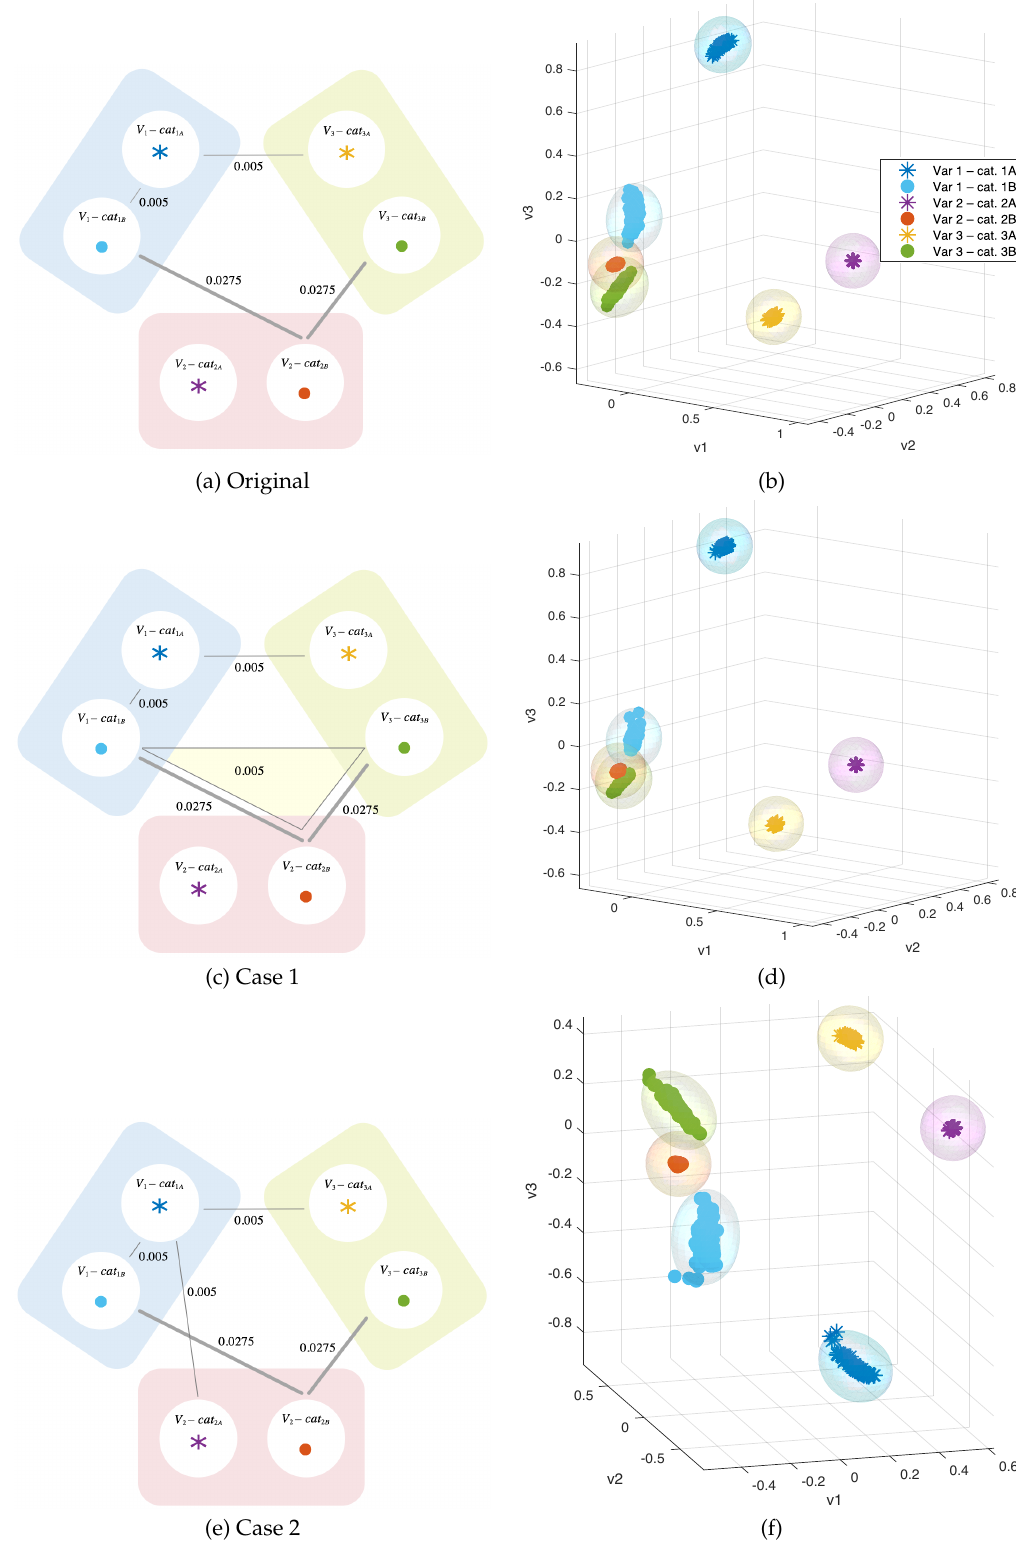
Figure 2. Schemes of the three situations to be scrutinized in the toy example ( a , c , d ), where V i with i = 1, . . . ,6 is the i th variable and cat ij with i = 1, . . . ,6 and j ∈ { A , B } the j jl category corresponding to the i th variable. The joint probability of occurrence is shown with a line of different thickness according to its value. The individual probabilities are obviated, as they are equiprobable. In ( b , d , f ) the projections of the original vectors onto the three most significant eigenvectors are depicted together with their Bootstrap-Parzen confidence regions for each